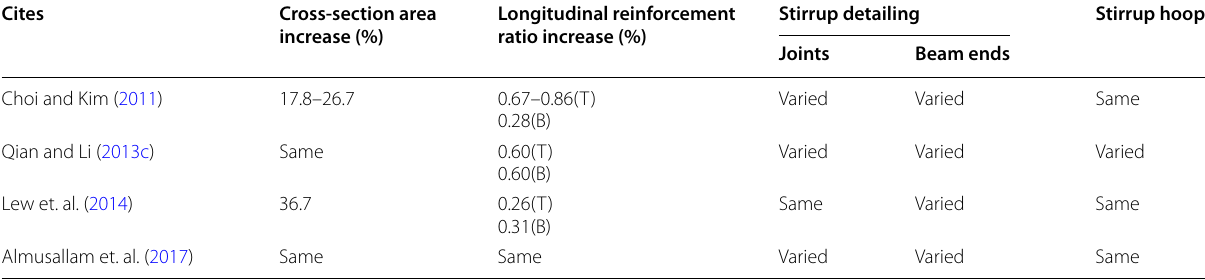
Table 3 Comparison of variables in experiments investigating seismic design.